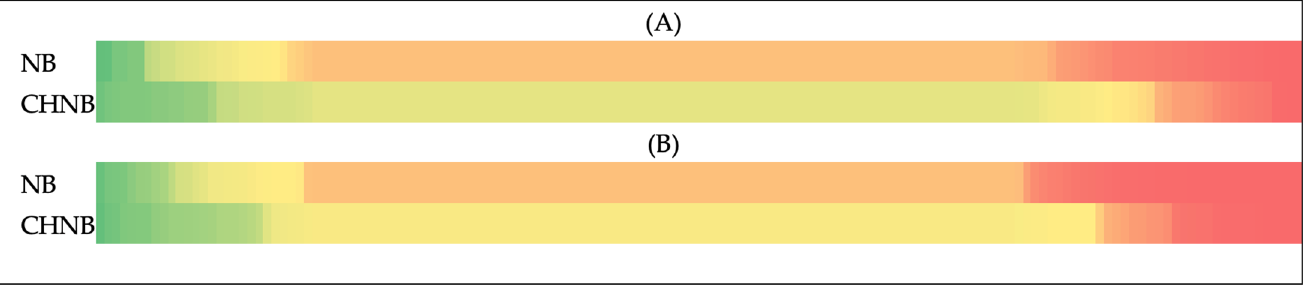
Figure 2. ( A ) Conditional probability terms absolute difference ( top ) and ( B ) the prevalence of adjusted absolute difference ( bottom ). Table 8. The probability terms for the binary-class dataset before and after fine-tuning.